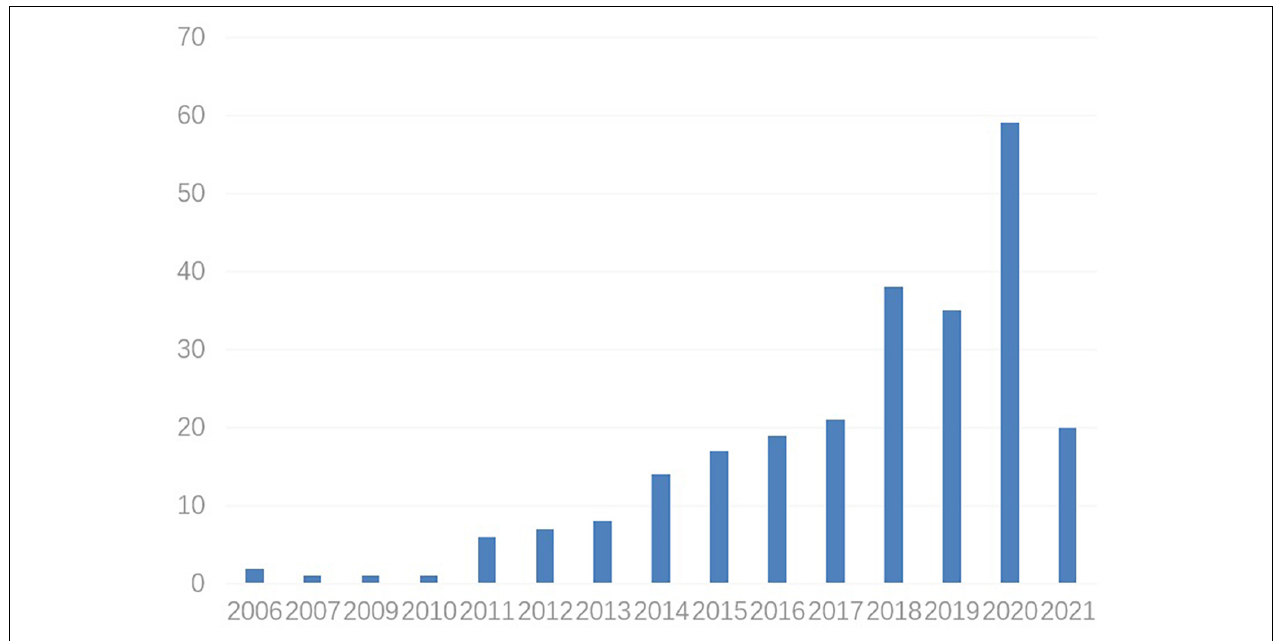
FIGURE 1 | Number of documents per year in BCI and emotions